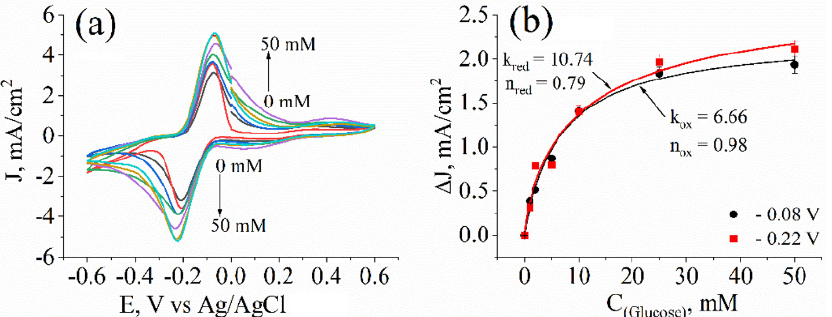
Figure 6. ( a ) Cyclic voltammograms of PPy − yeast − PQ-modified graphite electrodes at different glucose concentrations (from 0 to 50 mM). Measurements were performed in a buffer solution with 0.75 mM potassium ferricyanide. ( b ) Current density dependencies on glucose concentration calculated from the peak current at ( a ). Lines represent mathematical-modelling-based results generated using Hill’s function (Equation (6)), which are fitted to experimental data. Measurements were performed in a three-electrode electrochemical cell.